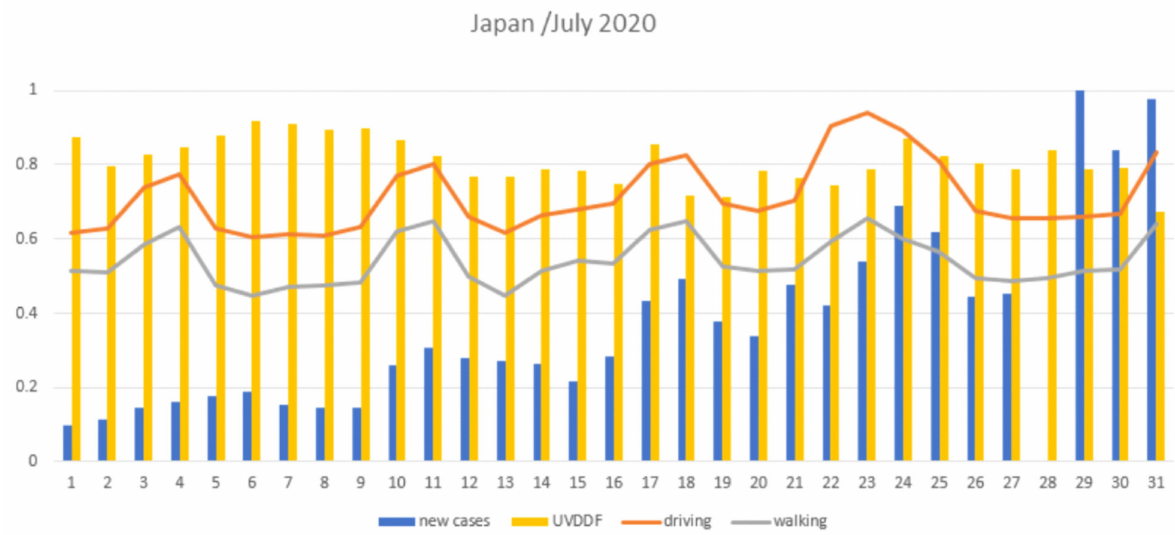
Figure 1. Example of Japan: new cases, driving, walking and DNA damage UV dose (UVDDF) data for July 2020. Day of the month ( x -axis) and (min-max) normalized values for daily cases (‘new cases’), UV (UVDDF) and mobility (driving, walking), as in legend. Despite an overall high UV level, the surge of Covid-19 cases towards the end of July is evident, as an exception to the rule (see text for